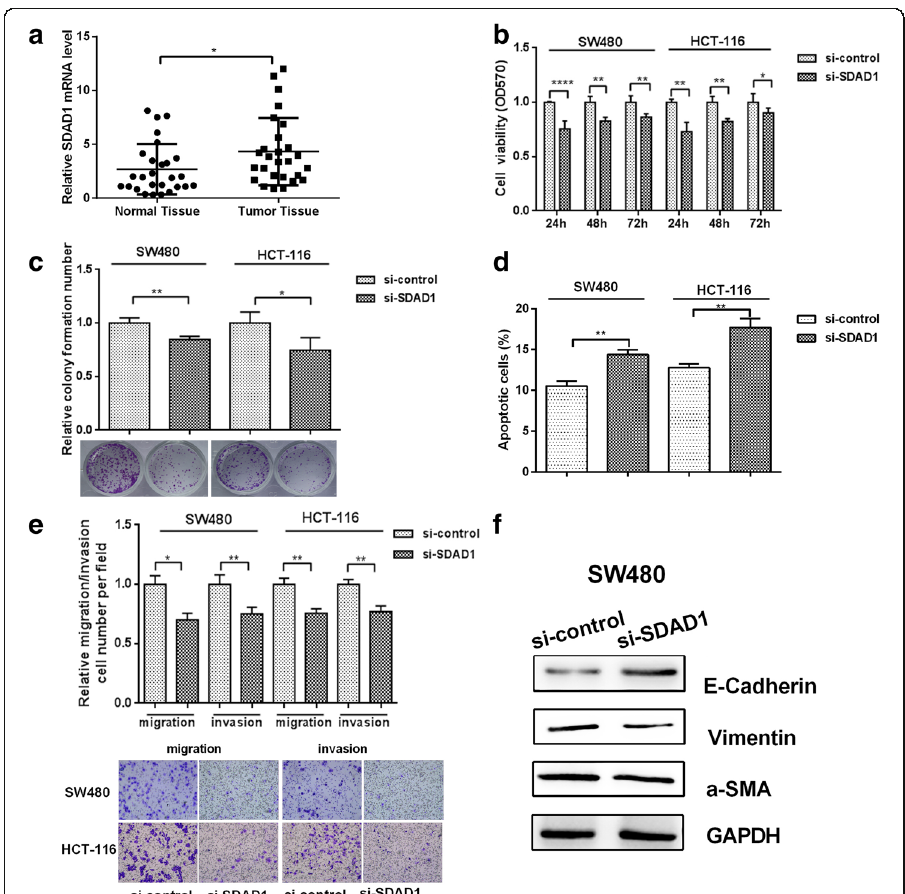
Fig. 5 SDAD1 promotes the proliferation, migration and invasion of colon cancer cells. a The expression of SDAD1 in 27 pairs of colon cancer and adjacent non-tumor tissues was determined using quantitative RT- PCR. b The MTT assay was performed on SW480 and HCT-116 cells transfected with SDAD1